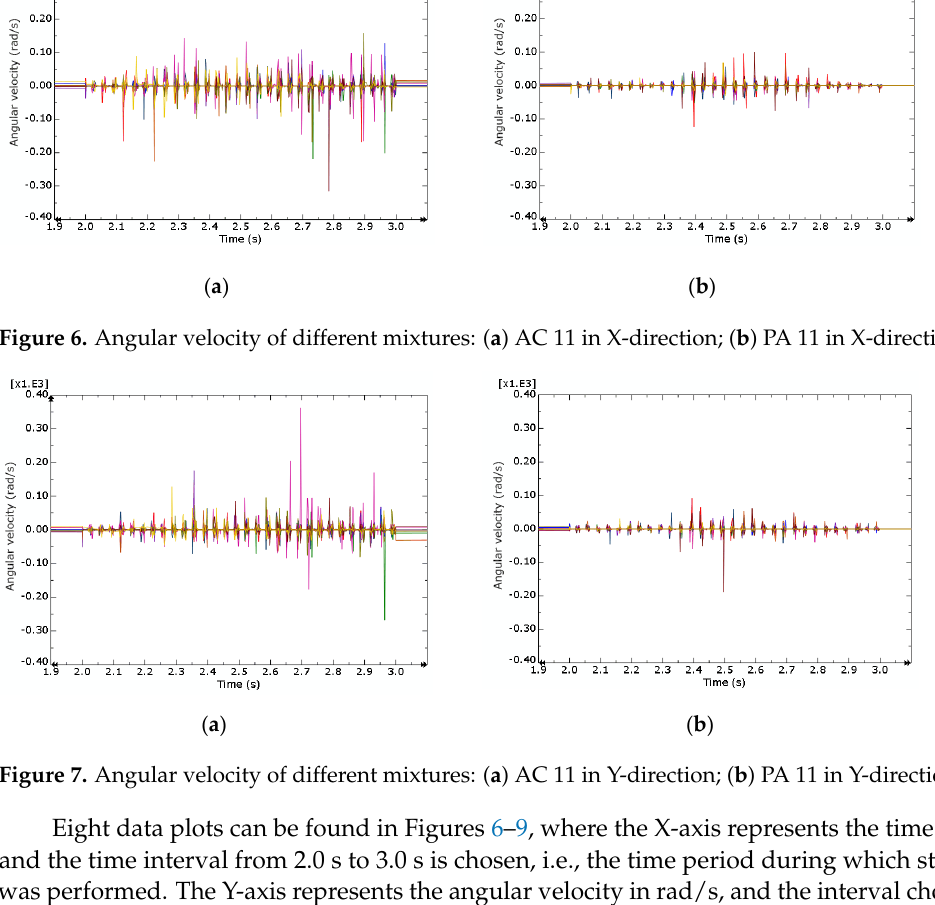
Figure 7. Angular velocity of different mixtures: ( a ) AC 11 in Y-direction; ( b ) PA 11 in Y-direction.